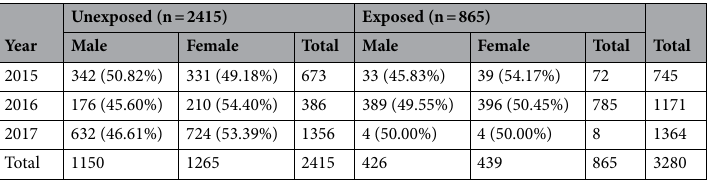
Table 1. Distribution of unexposed and exposed children by sex and year of study. Data are presented as n and (%).